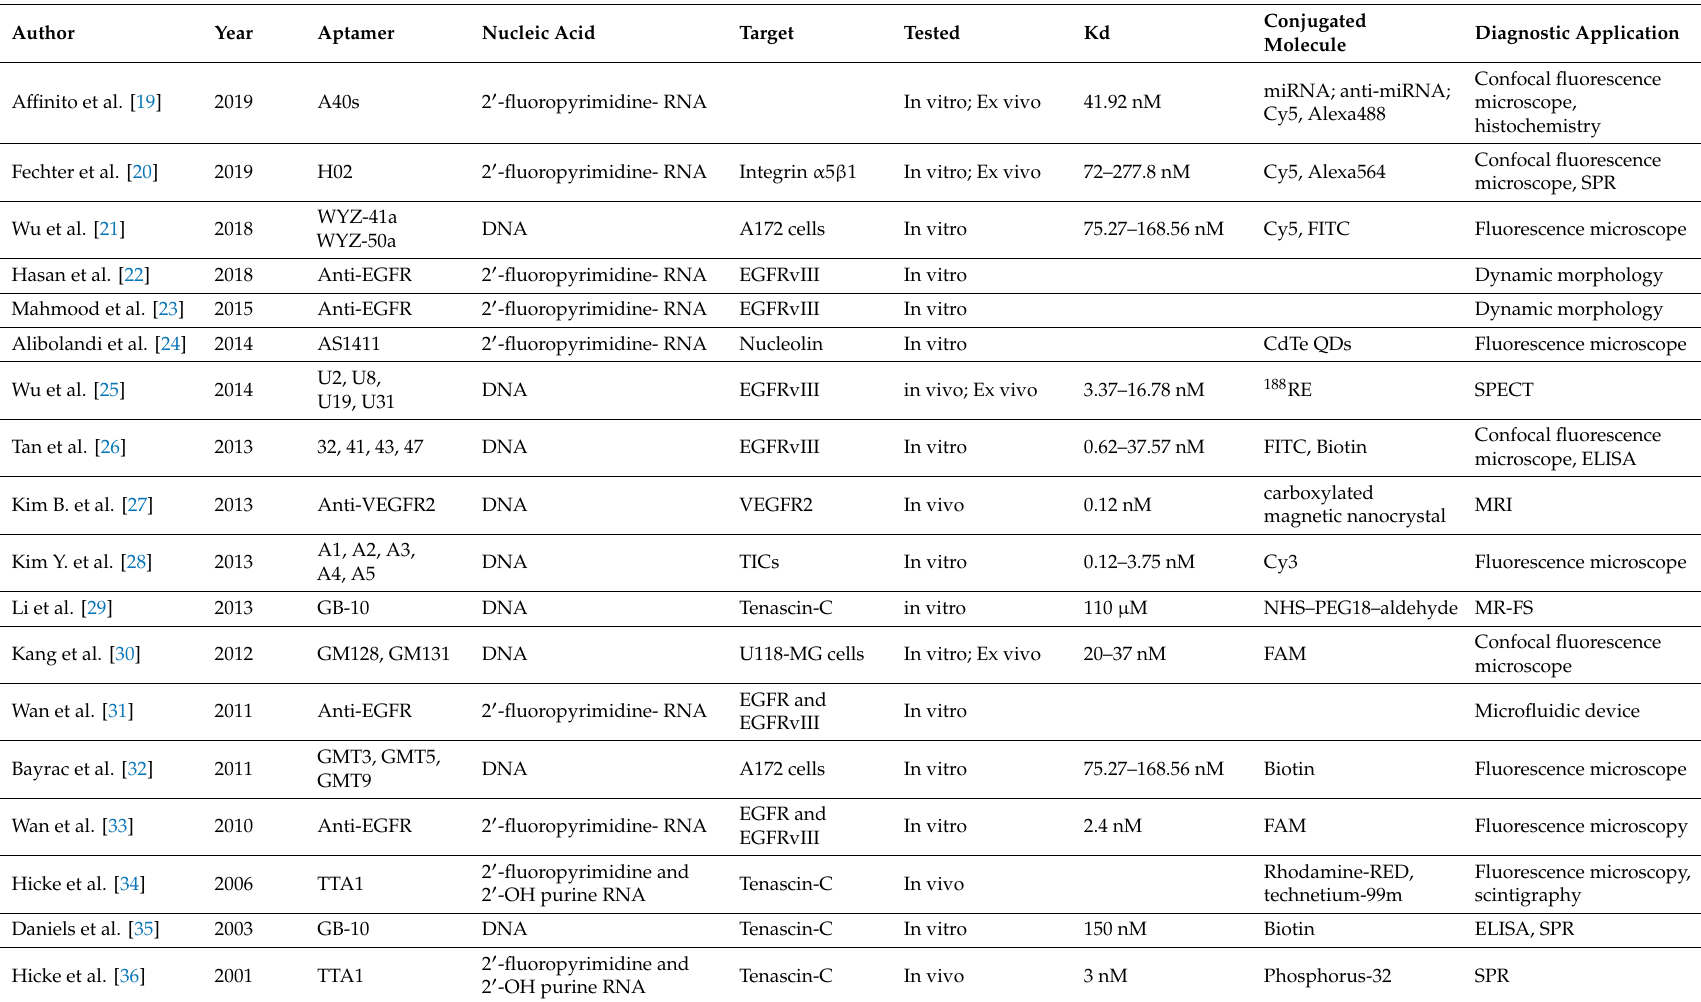
Table 1. Characteristics of included studies on diagnosis applications of aptamers in glioblastoma (GBM). Kd = dissociation